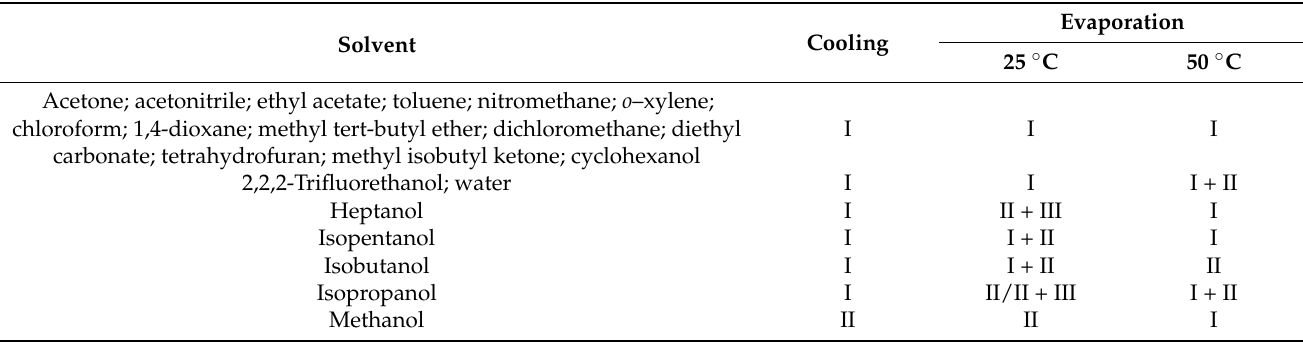
Table 1. Polymorphic outcome of crystallization from pure